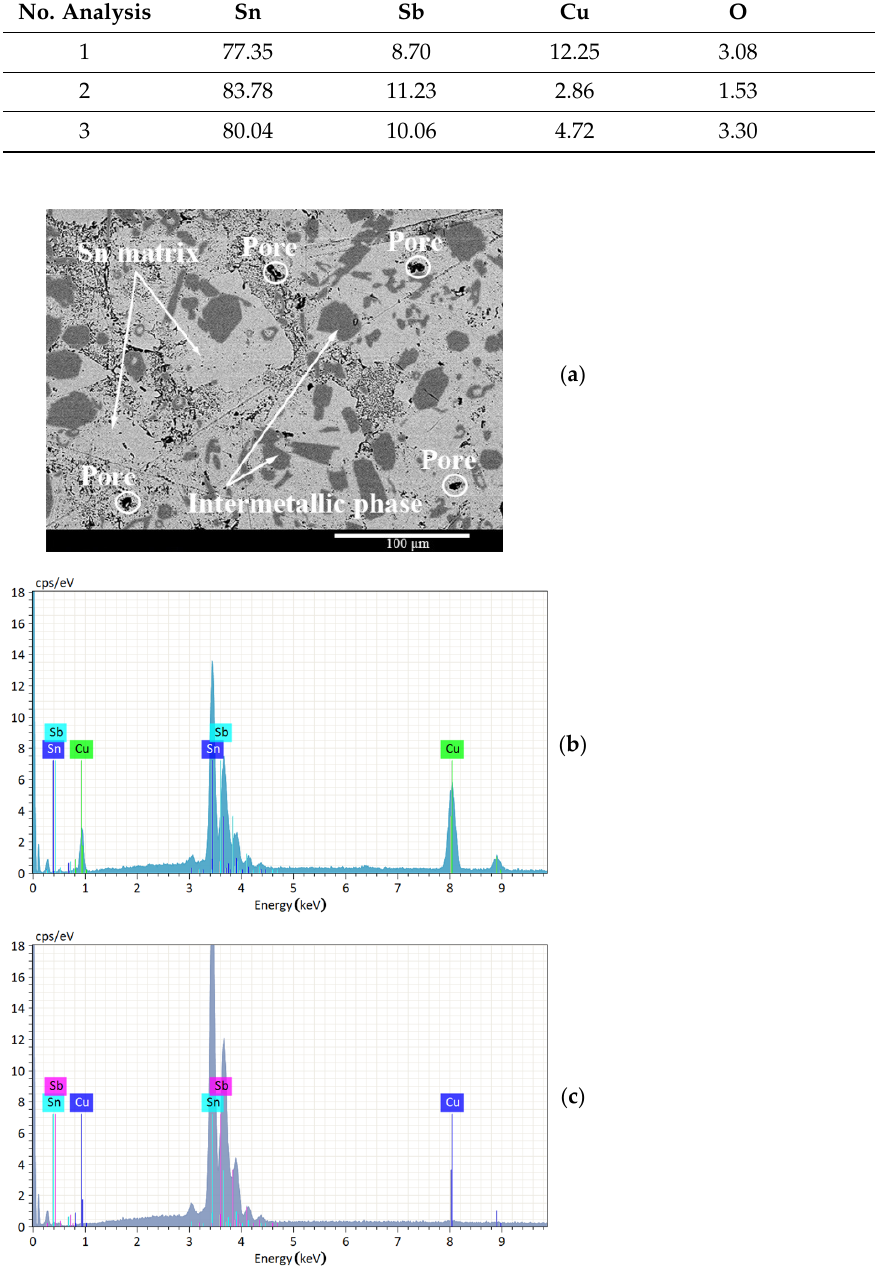
Figure 5. Wear surface of B83 babbitt at a load of 50 N: ( a ) SEM image; ( b ) EDX pattern of inter- metallic phase; ( c ) EDX pattern of Sn matrix. phase; ( c ) EDX pattern of Sn Table 7. EDX analysis of selected zones from Figure 4c of the wear surface of B83 babbitt at a load of 50 N, mass norm., %.